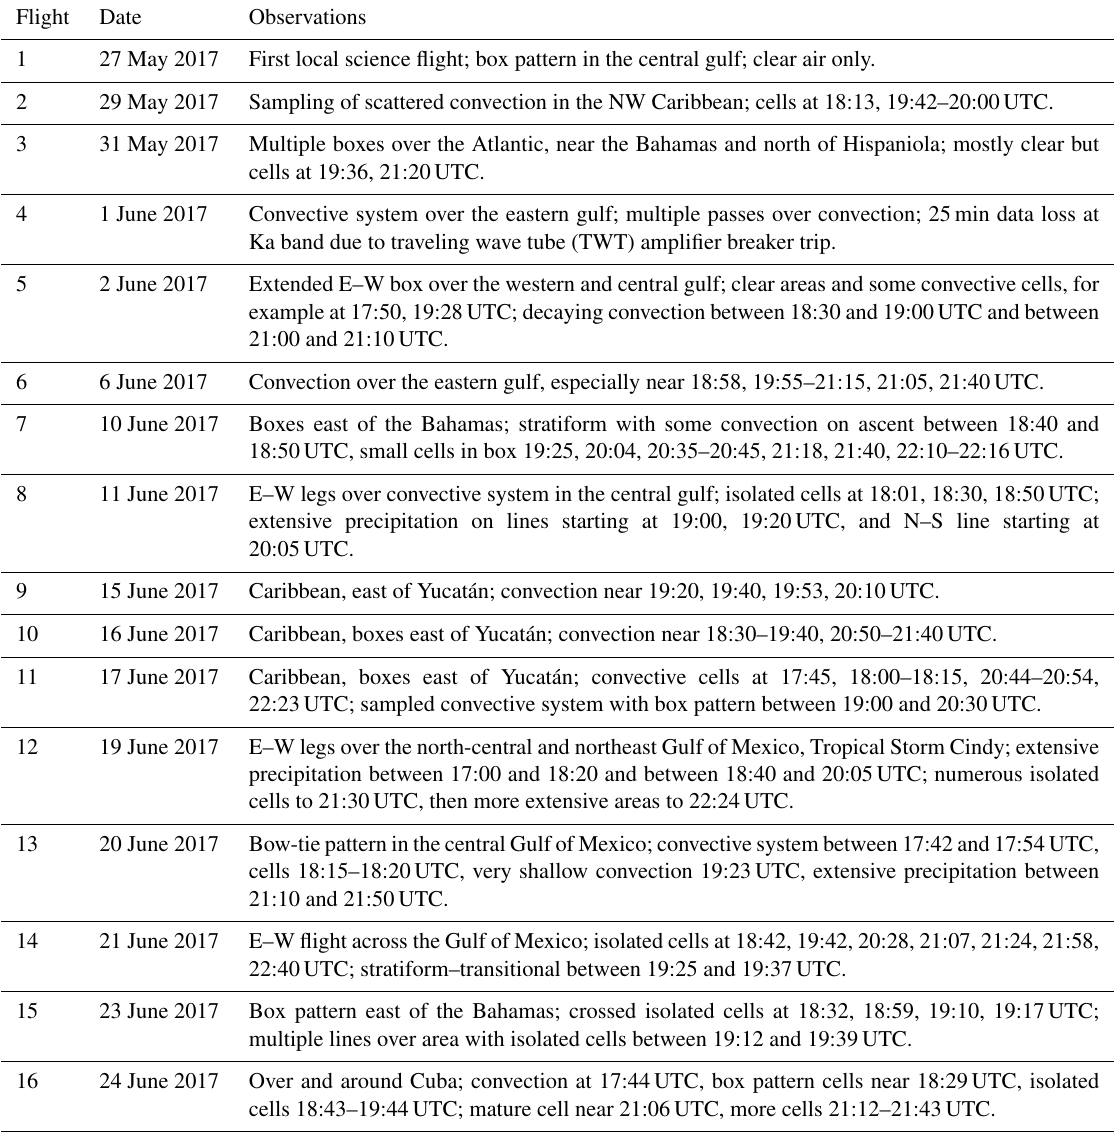
Table 1. Summary of CPEX flight